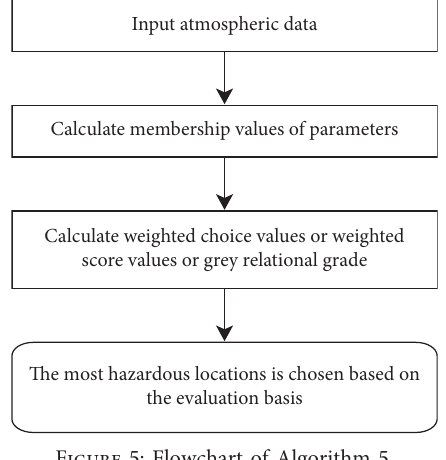
Figure 5: Flowchart of Algorithm